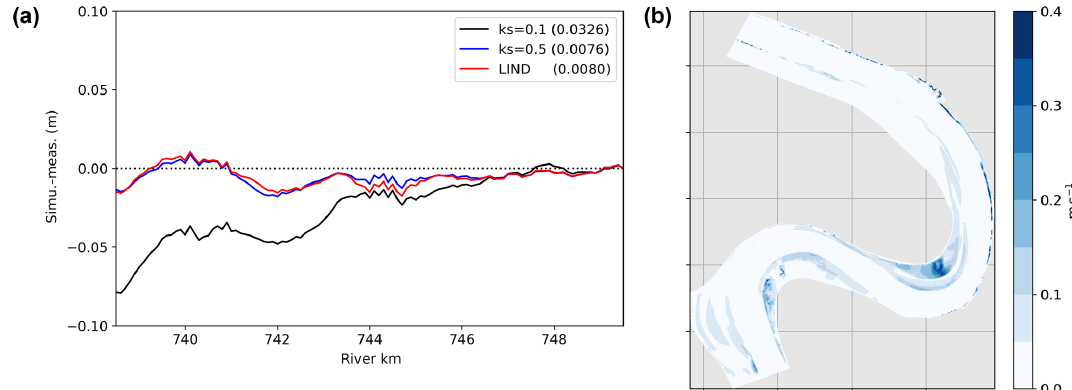
Figure 2. Water level difference along the river channel axis for different floodplain friction values (a) , and absolute difference of the flow velocity with and without floodplain friction formulation (b) .